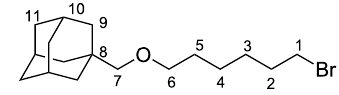
the cases where the experimental protocol required an inert gas